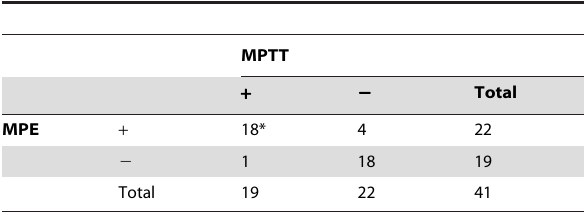
Table 6. Kappa value and Youden index of EGFR mutations in MPPT and that in MPE